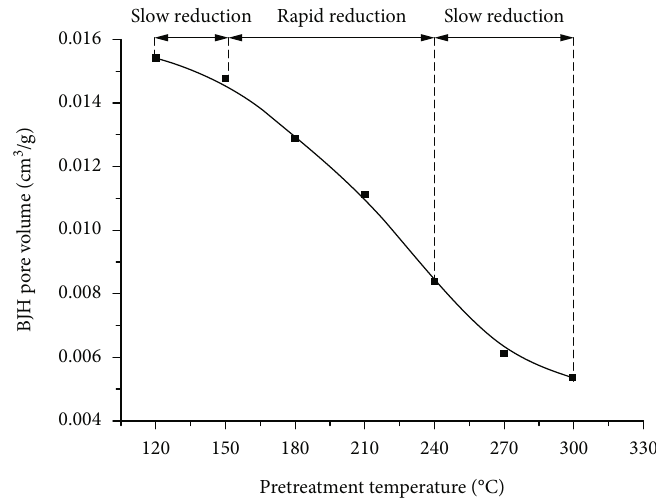
Figure 3: The dynamic change of total PV under various pretreatment temperatures.